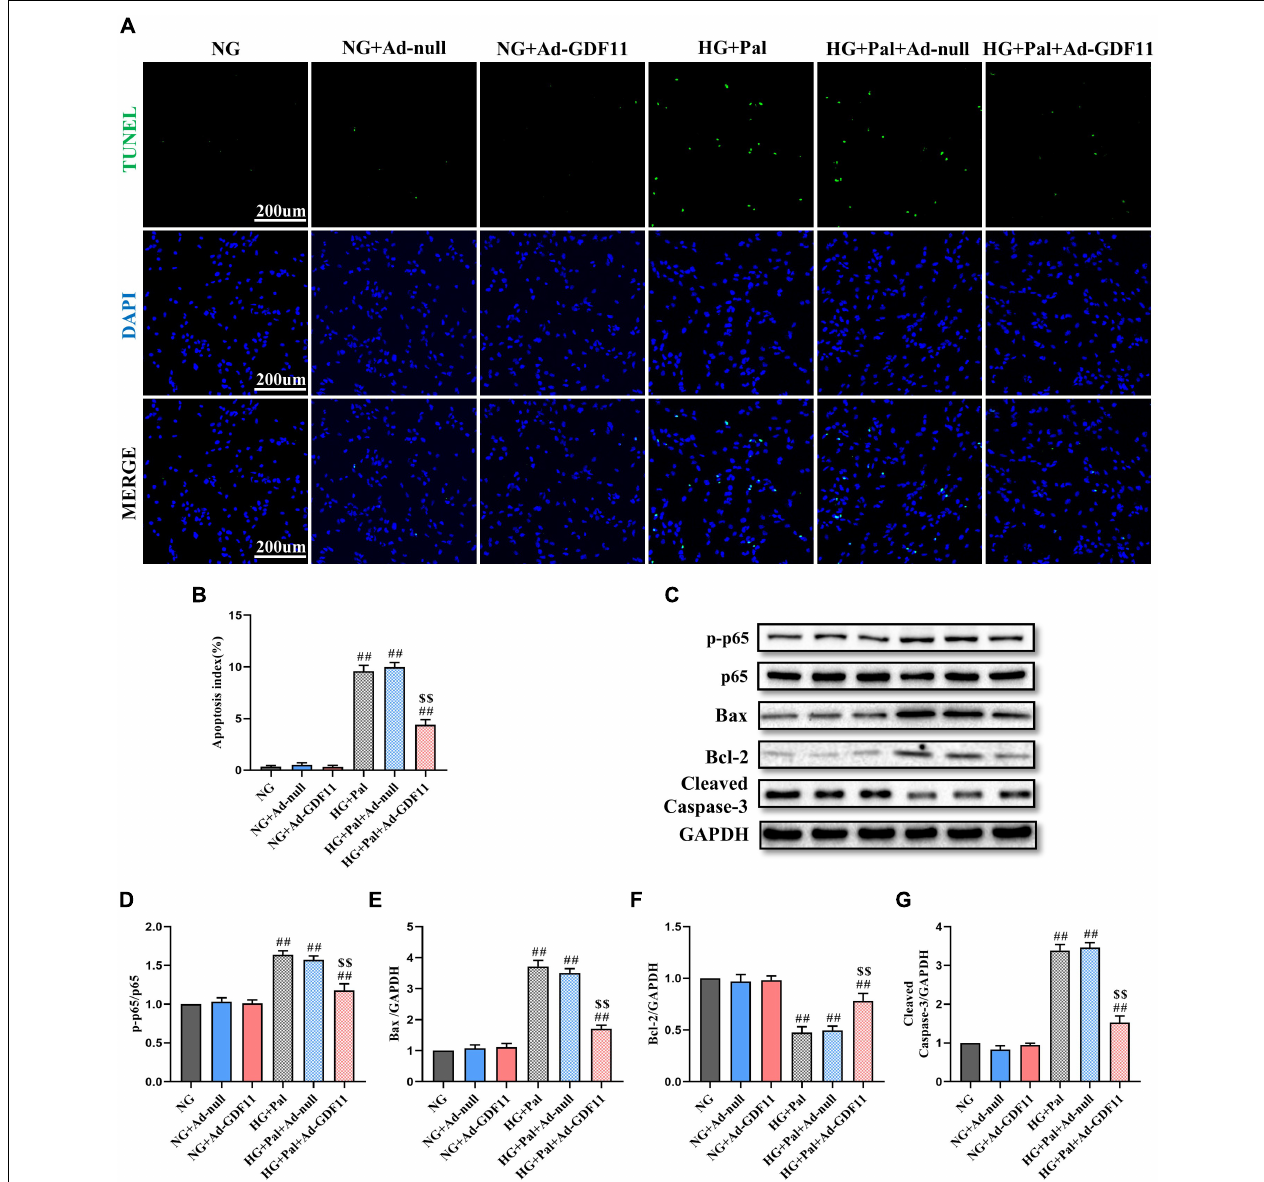
FIGURE 7 | GDF11 decreased high glucose (HG) and palmitate (Pal) induced apoptosis in vitro . (A) Representative images of TUNEL staining (scale bar = 200 µ m). (B) Apoptotic ratio. (C) Representative blots of p-p65, p65, Bax, Bcl-2, and Cleaved Caspase-3. (D) Quantitative analysis of the ratio of p-p65 to p65. (E) Quantitative expression of Bax. (F) Quantitative expression of Bcl-2. (G) Quantitative expression of Cleaved Caspase-3. Data are presented as the mean ± SEM, n = 5 or 6 per group. ## P < 0.01 versus the NG group, $$ P < 0.01 versus the HG + Pal group.